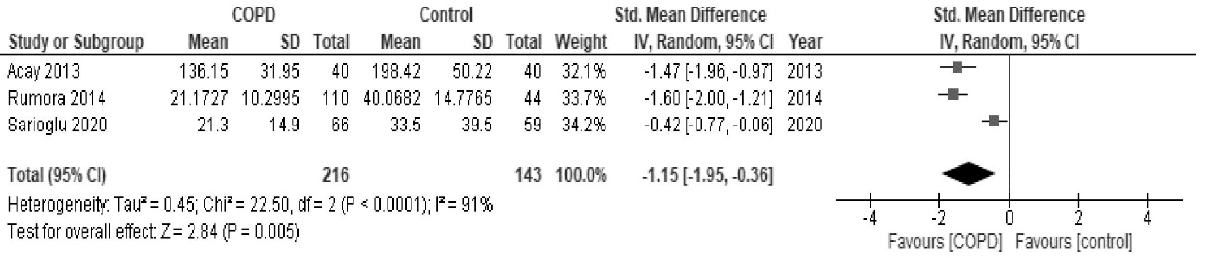
Figure 3. Forest plot of arylesterase activity in all studies.